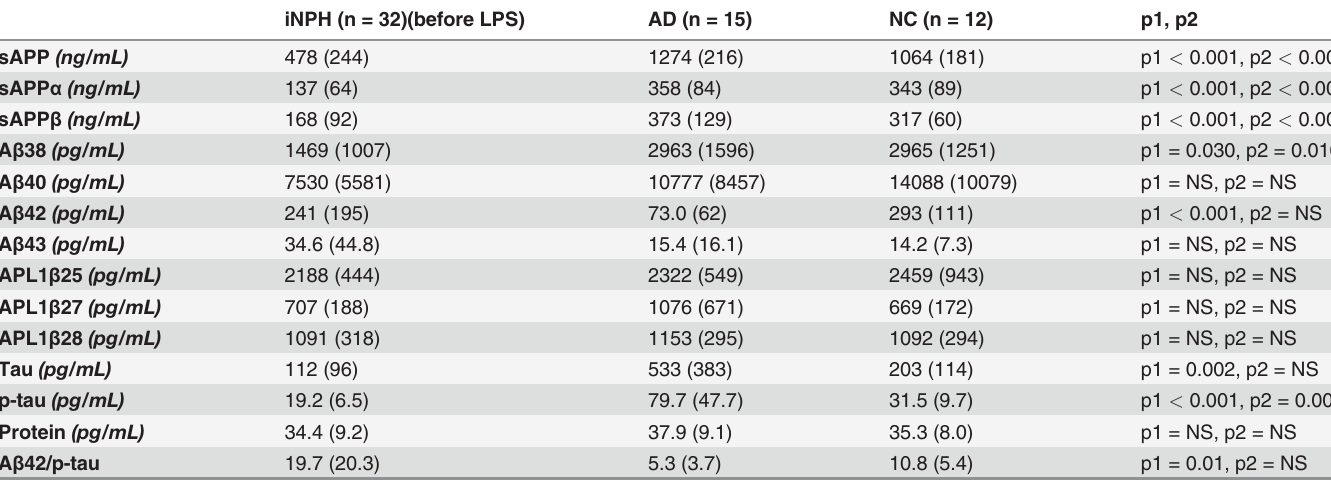
Table 2. Comparison of CSF values between